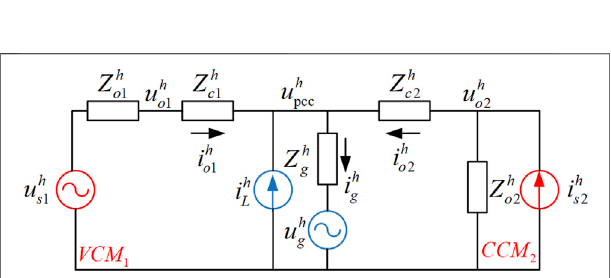
FIGURE 2 | Equivalent circuit with a VCM and a